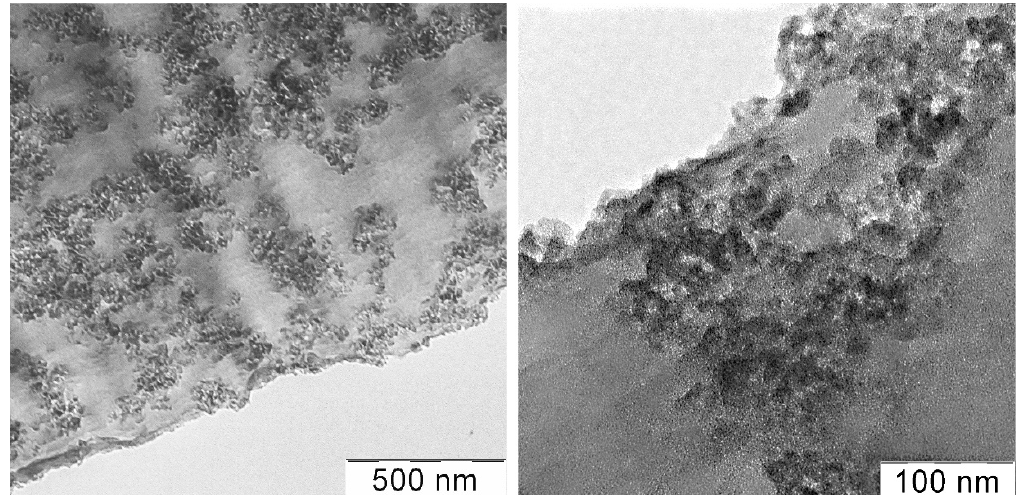
Figure 11. TEM images of a film section cast from a PAN solution containing 15 wt% silica (at the polymer weight) at various magnifications.